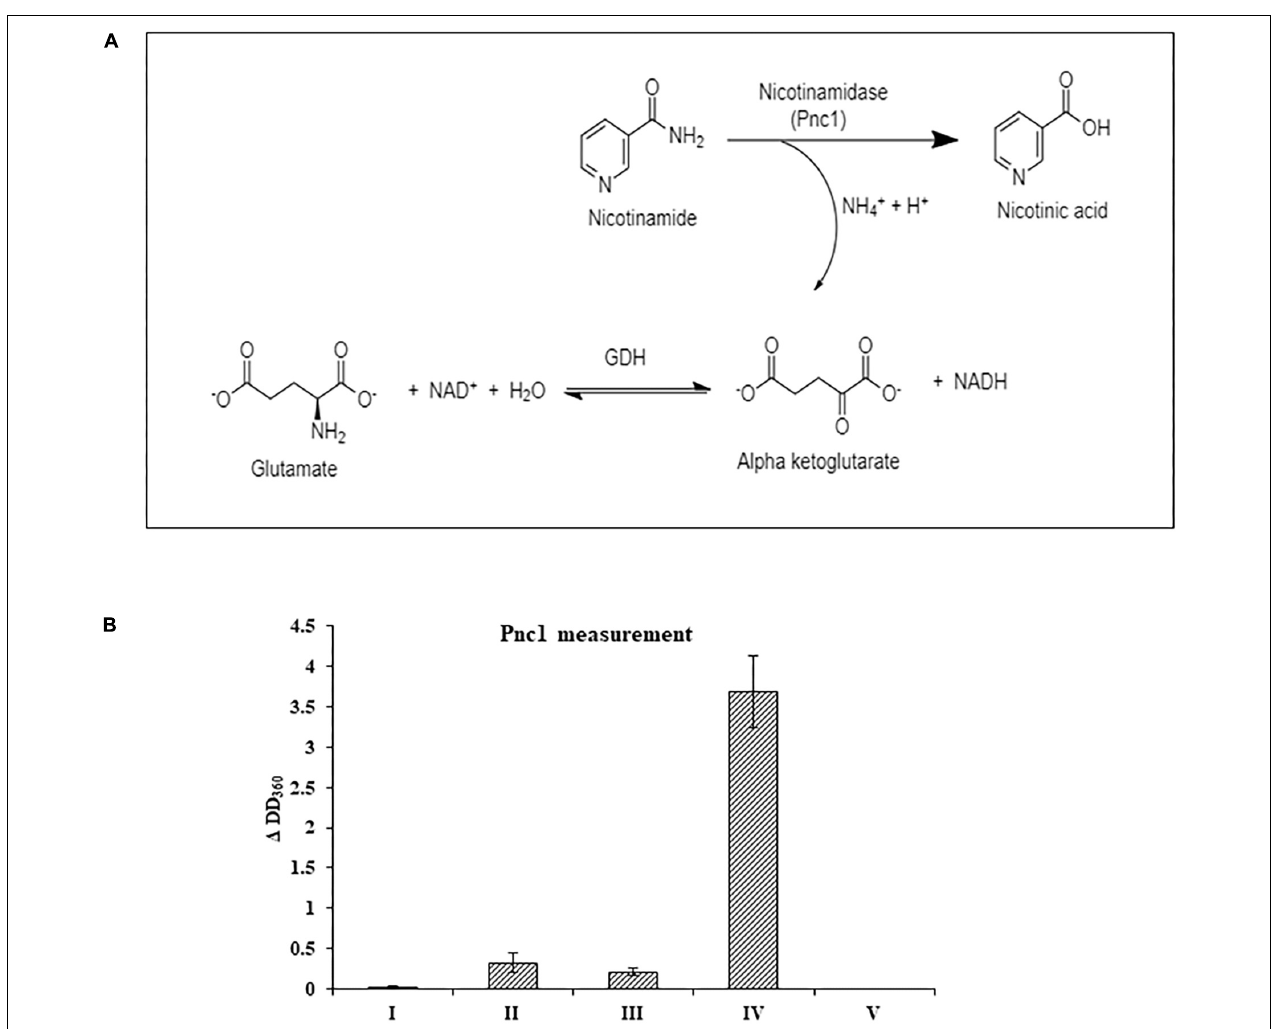
FIGURE 6 | The effect of NA on nicotinamidase activity in extracts of F. oxysporum. (A) An assay to measure nicotinamidase activity that is attributed to Pnc1. GDH, glutamate dehydrogenase (B) Nicotinamidase activity is completely inhibited by 10 mM NA. Nicotinamidase activity was measured as described in Materials and Methods. Values are mean ± SD and statistically significant with respect to control ( p < 0.05). Vertical lines represent standard error bars. I, without fungal extract; II, without nicotinamide and α -ketoglutarate; III, without nicotinamide; IV, with NAM, α -ketoglutarate and fungal extract; V, as in IV, but with 10 mM